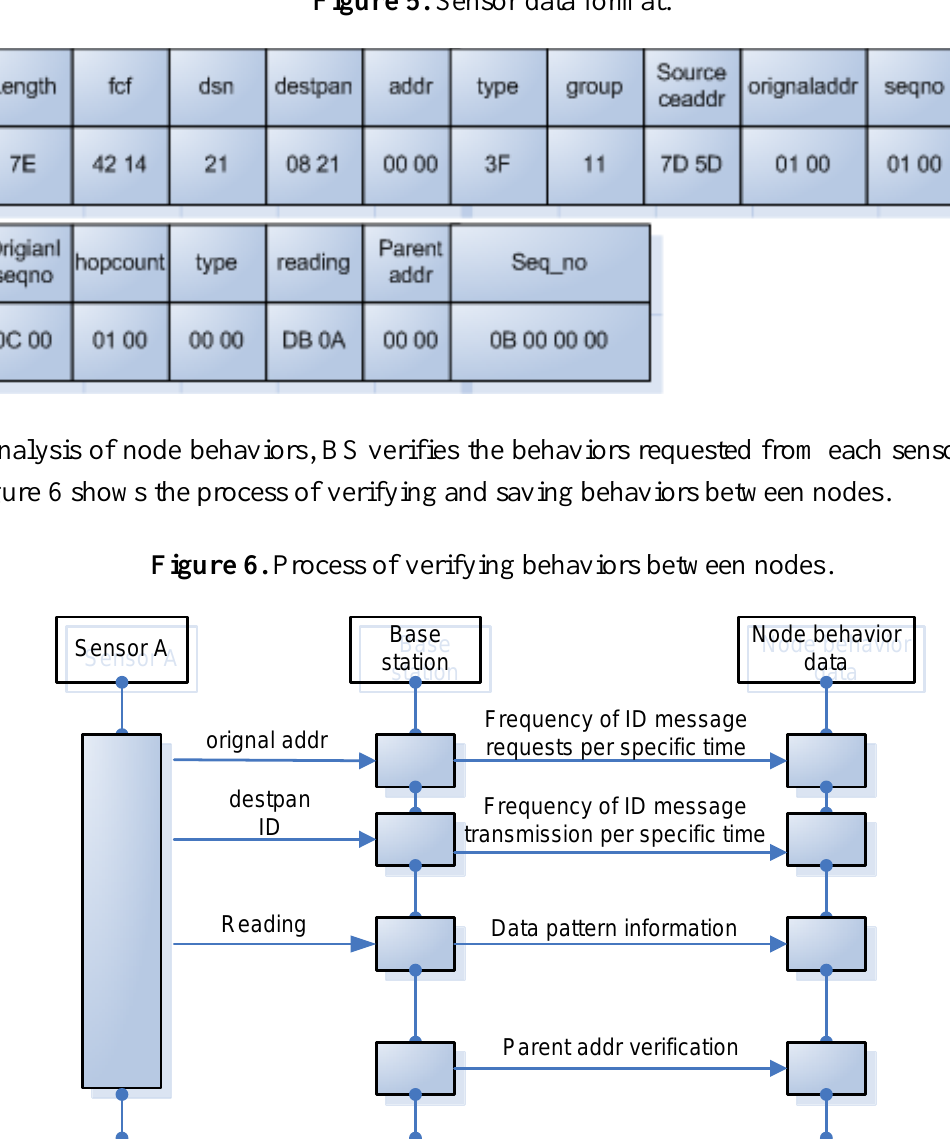
Figure 5. Sensor data format.